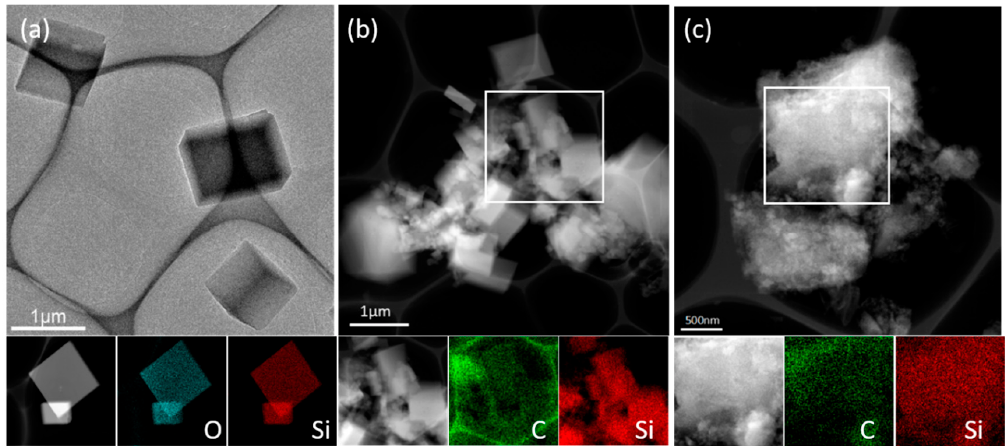
Figure 3. Transmission electron microscope (TEM) image and an area elemental mapping of poss ( a ), polymer ( b ) and Si@C ( c ).